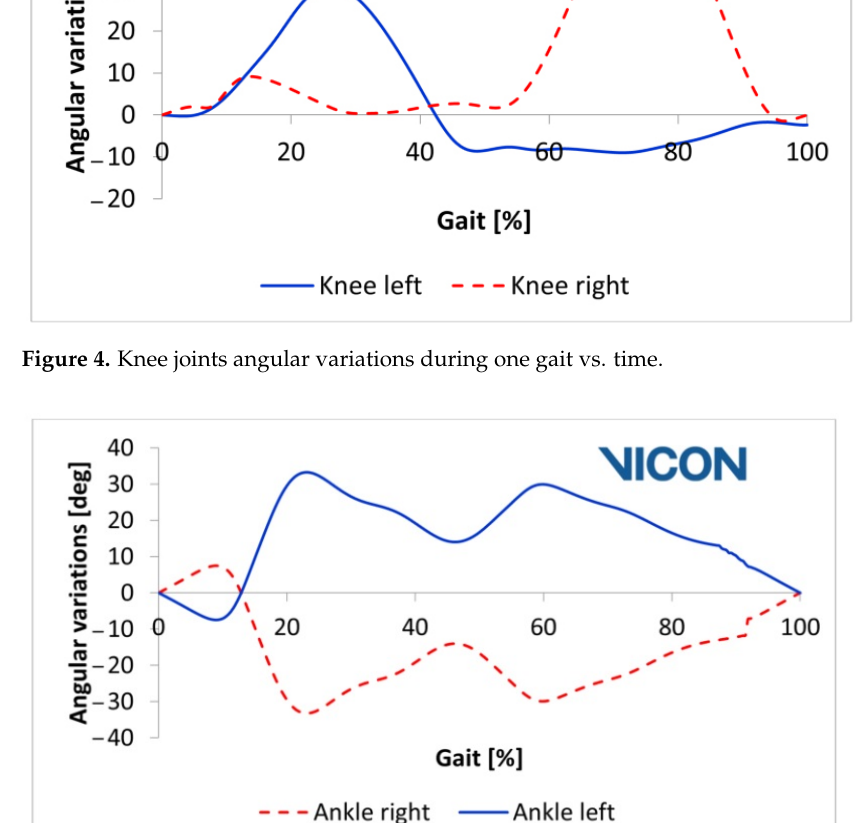
Figure 5. Ankle joints angular variations during one gait vs. time.